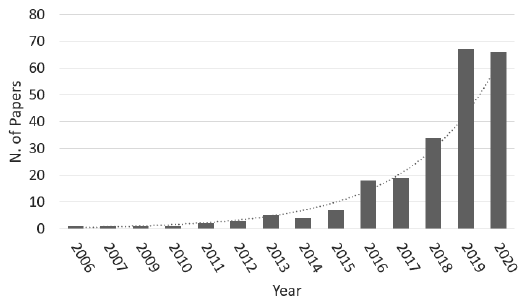
Figure 1. Number of publications per year: search results for the joint keywords “machine learning” and “cancer surgical risk” on PubMed, accessed on January